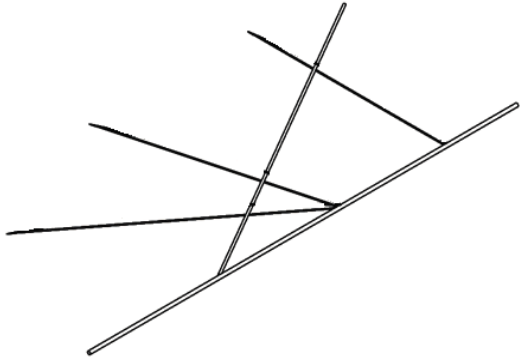
Figure 23. Skeletal structure for Orcon flat wing (CAD